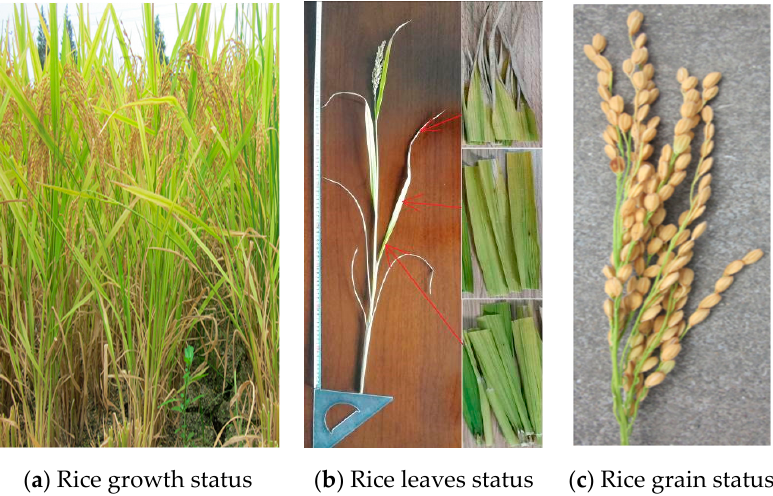
Figure 2. Status of rice plant and rice leaves and rice ear with grain.